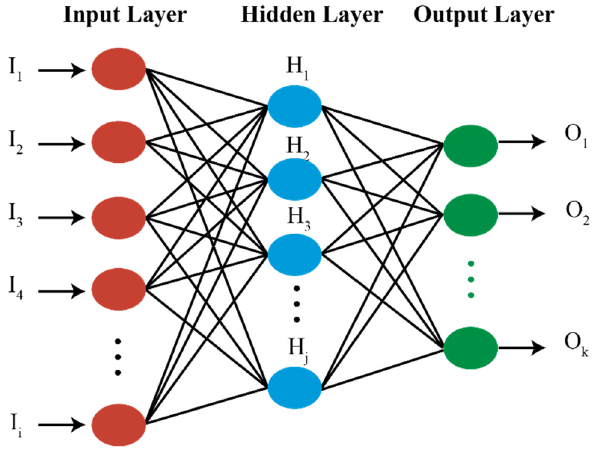
Figure 10. FFNN Figure 10. FFNN architecture.